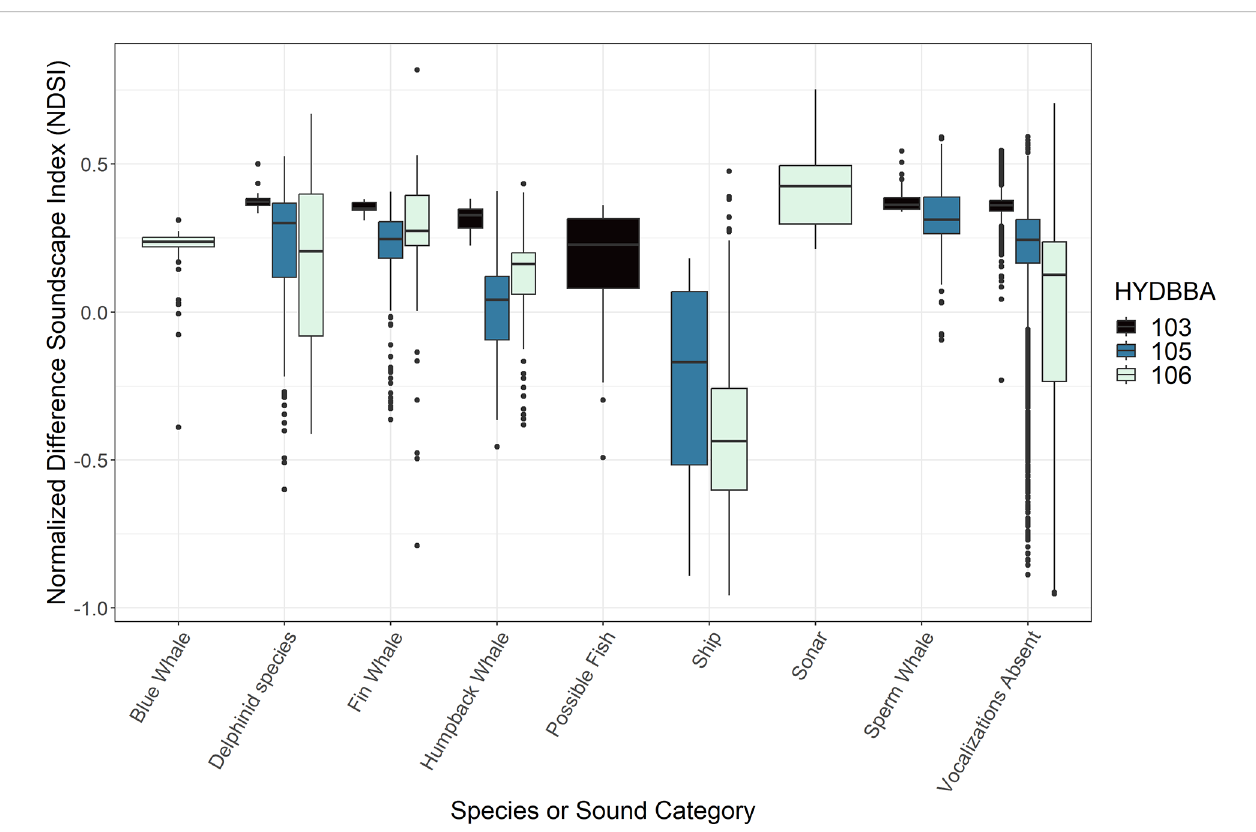
FIGURE 4 Box plots representing measurements of Normalized Difference Soundscape Index (NDSI) associated with underwater sounds. Data are organized by recorders located on the shelf (106), the slope (105) and at the base of the slope (103). Marine mammal species and human-made sounds vary for each recorder resulting in some sound types with only one or two box plots. All recorders include a plot for data that contained no annotated sound (labeled ” Vocalizations Absent “